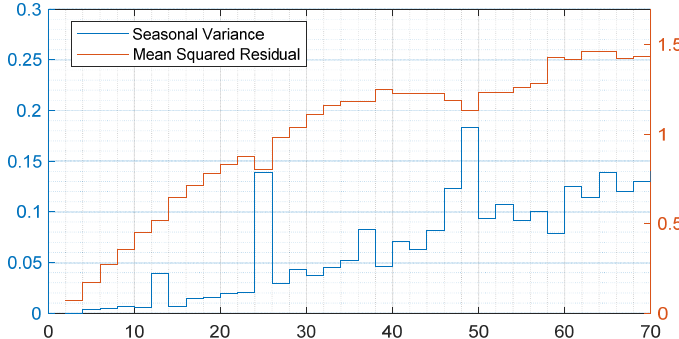
Figure 3. Seasonal Variance and Mean Squared Residual for different seasonality windows length. Two optimal values where both the variance is high, and the residual is low can be found for 24 h and 48 h.